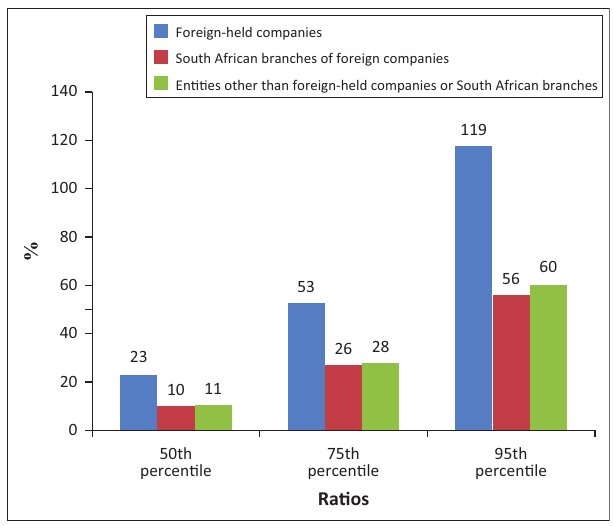
FIGURE 2: Interest-to-earnings before interest, taxes, depreciation, and amortisation (EBITDA) ratios for companies with turnover between R1 million and R20 million.